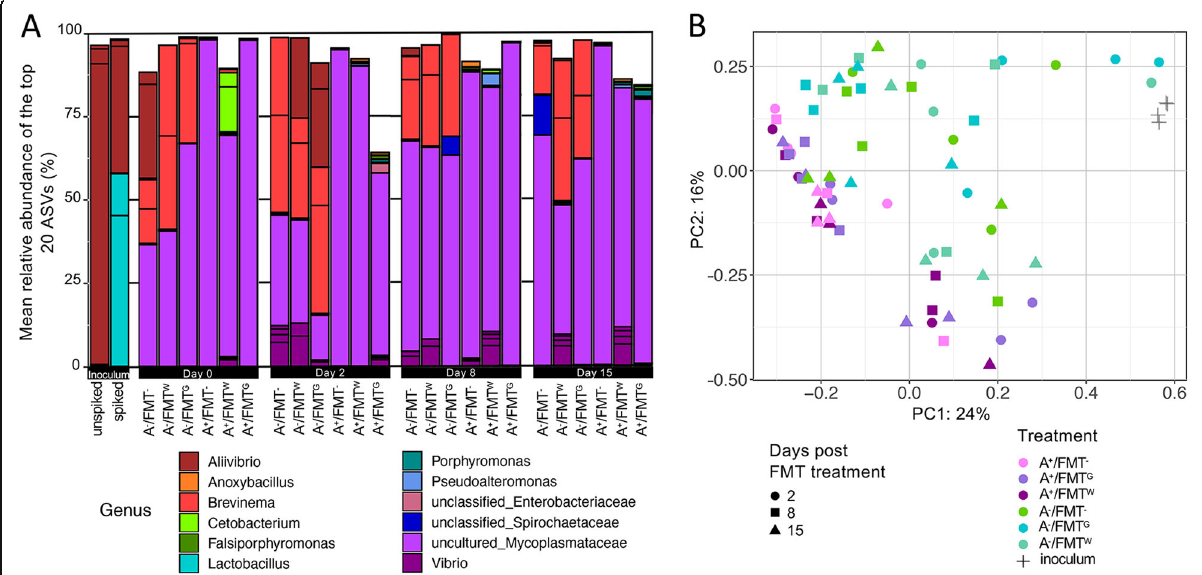
Fig. 4 Impact of FMT on antibiotic perturbed and unperturbed gut microbiota. a Stacked barplot presenting the mean relative abundance (%) of the top 20 bacterial ASVs found in the healthy donor inoculum compared to the fish from the different treatment groups; A − /FMT − , A + /FMT − , A − / FMT G , A + /FMT G , A − /FMT W and A + /FMT W . Mean from n = 4 fish. b PCoA plot representing Bray-Curtis similarities, comparing global gut bacterial communities between the treated (antibiotic and/or FMT) and untreated fish to the donor inoculum, comparing treatment effects for 15 days post